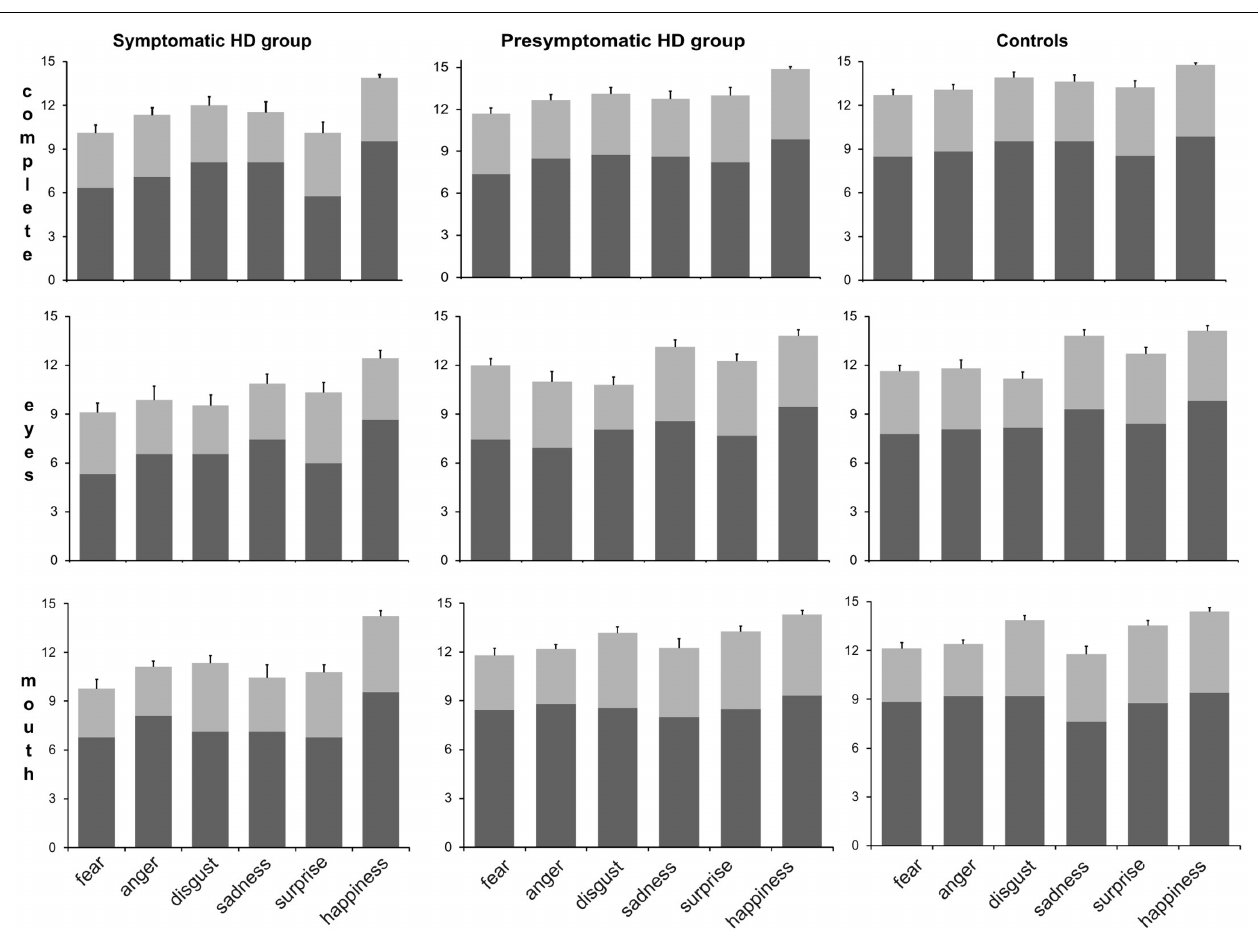
FIGURE 3 | Results of the forced-choice emotion recognition task. Number of correct responses (SE) separated for the three groups, the three